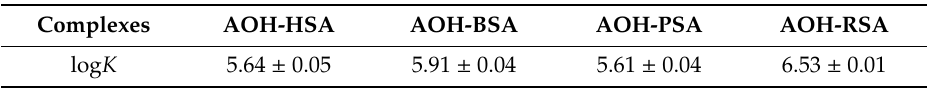
Figure 11. Fluorescence emission spectrum of AOH (1 μ M) in the absence and presence of human (HSA), bovine (BSA), porcine (PSA), and rat (RSA) serum albumins (each 10 µ M) in PBS (pH 7.4) ( λ ex = 345 nm; spectra were corrected with the background fluorescence of albumin preparations). Table 3. Decimal logarithmic values of binding constants ( K ; unit: L / mol) of AOH-albumin complexes. Data represent means ± SEM ( n = 3).